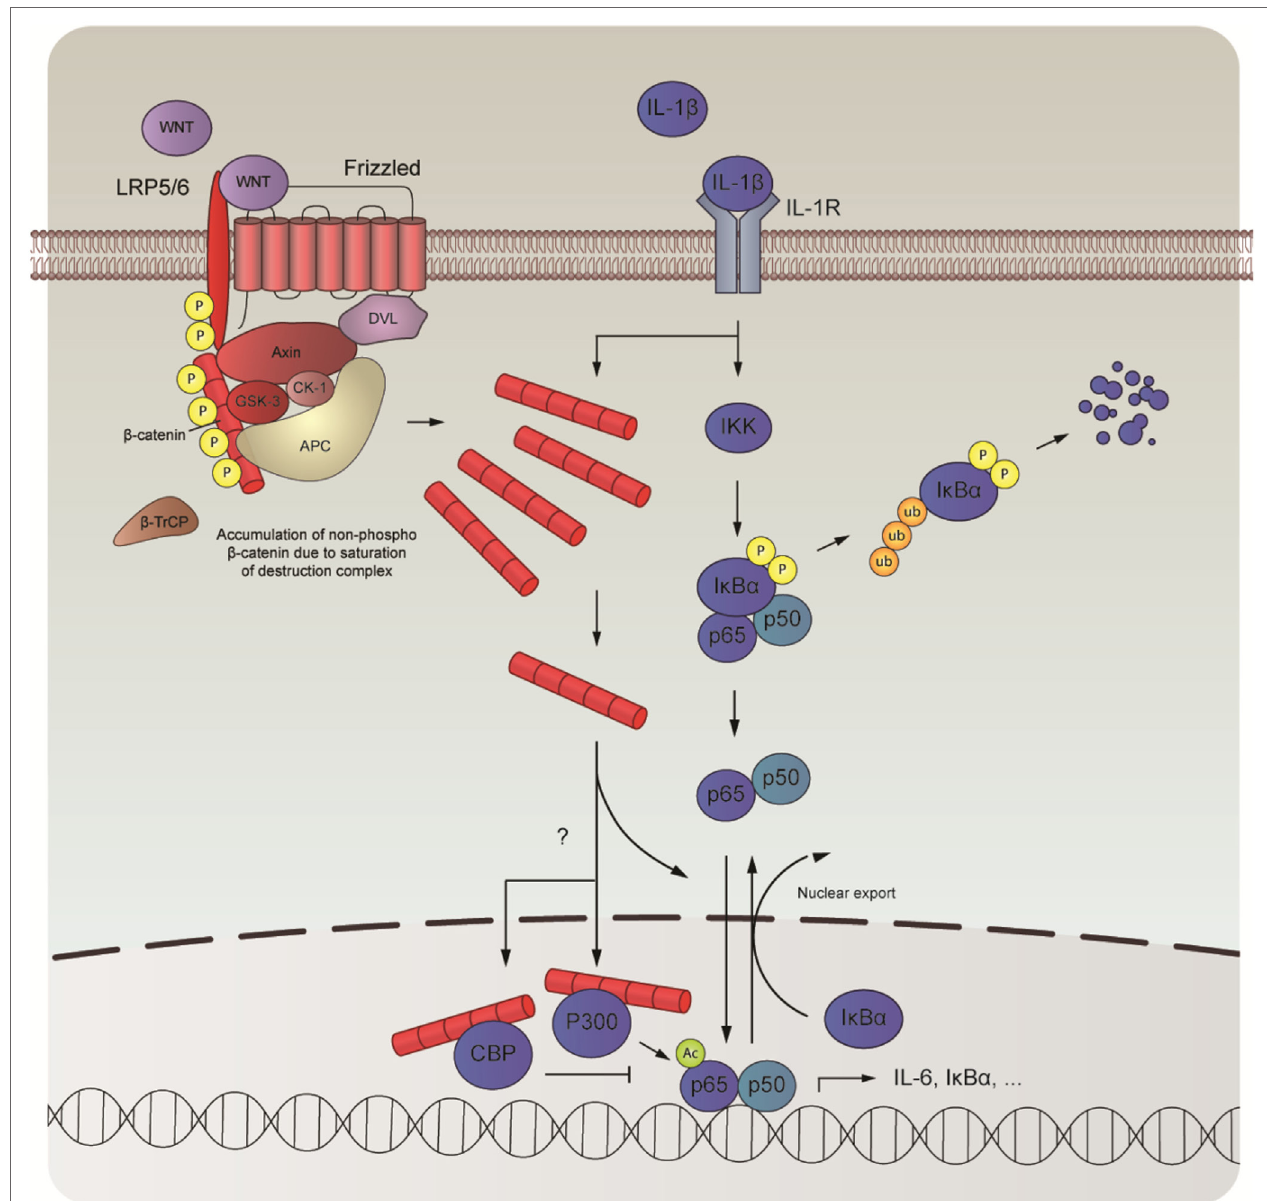
FigUre 6 | Schematic overview of the interaction between nuclear factor- κ B (NF- κ B) and β -catenin. In human airway smooth muscle, interleukin-1 β (IL-1 β ) drives the expression of proinflammatory genes, such as IL-6, by interacting with the WNT-effector β -catenin. Although IL-1 β does not directly influence expression levels of β -catenin, it directs its nuclear import together with the NF- κ B dimer to facilitate DNA-binding of p65. Inside the nucleus, β -catenin teams up with either CREB- binding protein (CBP) or P300, two mutually exclusive events that are necessary for transcriptional output by p65. While direct competition between CBP and P300 likely underlies binding with β -catenin, alternative mechanisms may also be at play. When bound, p65 is acetylated, which likely governs its subsequent transcriptional